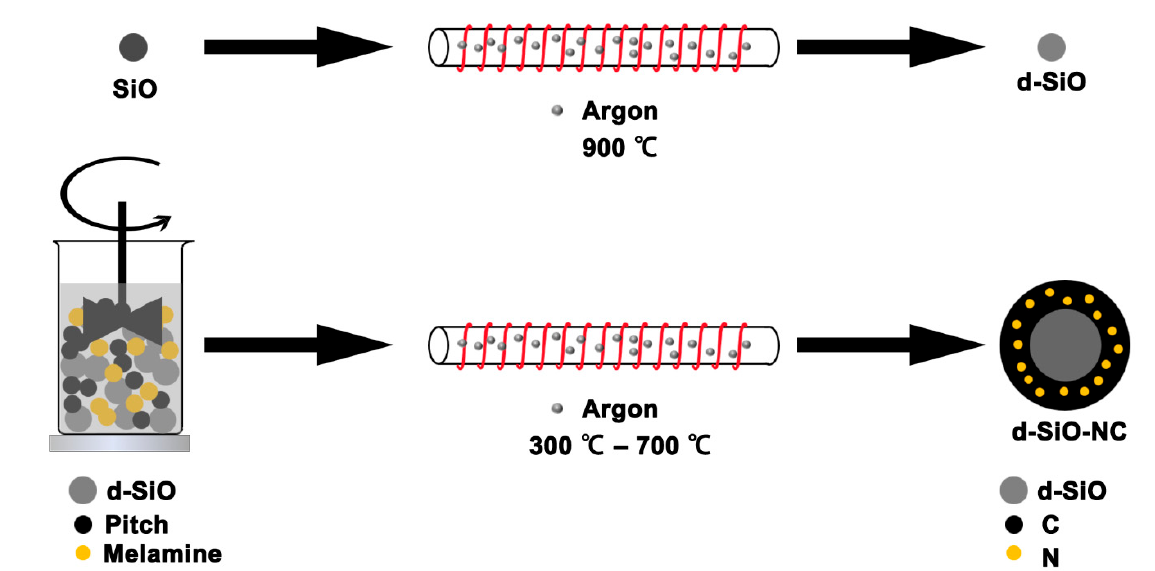
Figure 1. Schematic illustration of preparing nitrogen-doped carbon-coating disproportionated silicon monoxide (d-SiO-NC).